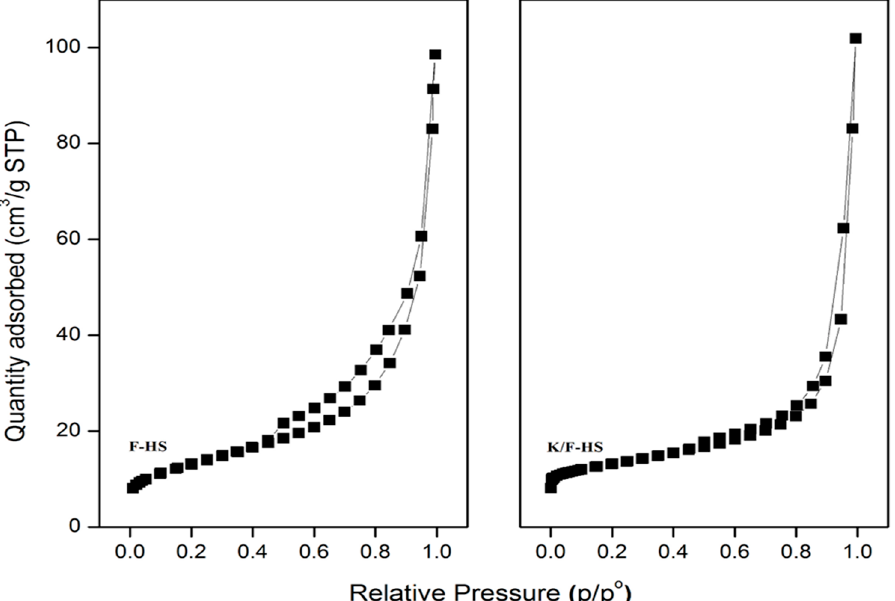
Figure 5. N 2 adsorption-desorption isotherms of fusion hydrothermal F-HS zeolite and ion exchange-modified K/F-HS zeolite.